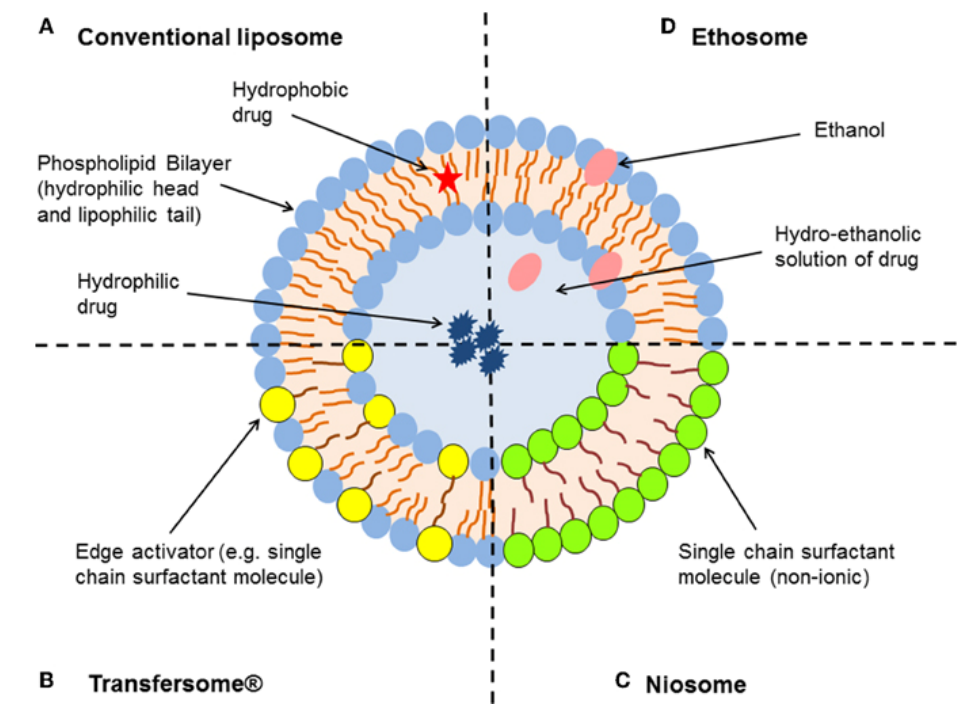
Figure 7. Comparative pictorial representation of conventional liposome ( A ), transfersome ( B ), niosome ( C ) and ethosome ( D ). (Reproduced with permission from [117] and Frontiers in accordance with the Creative Commons Attribution License).